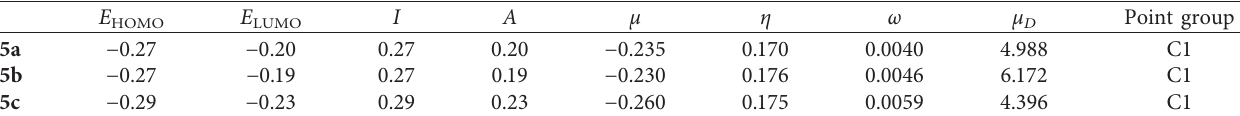
Table 12: Absolute energy (a.u), dipole moment ( μ , Debye), frontier orbital energies (HOMO and LUMO, eV), hardness ( η , eV), chemical potential ( μ , eV), and electrophilicity ( ω , eV) of 5a , 5b , and 5c molecules. E HOMO